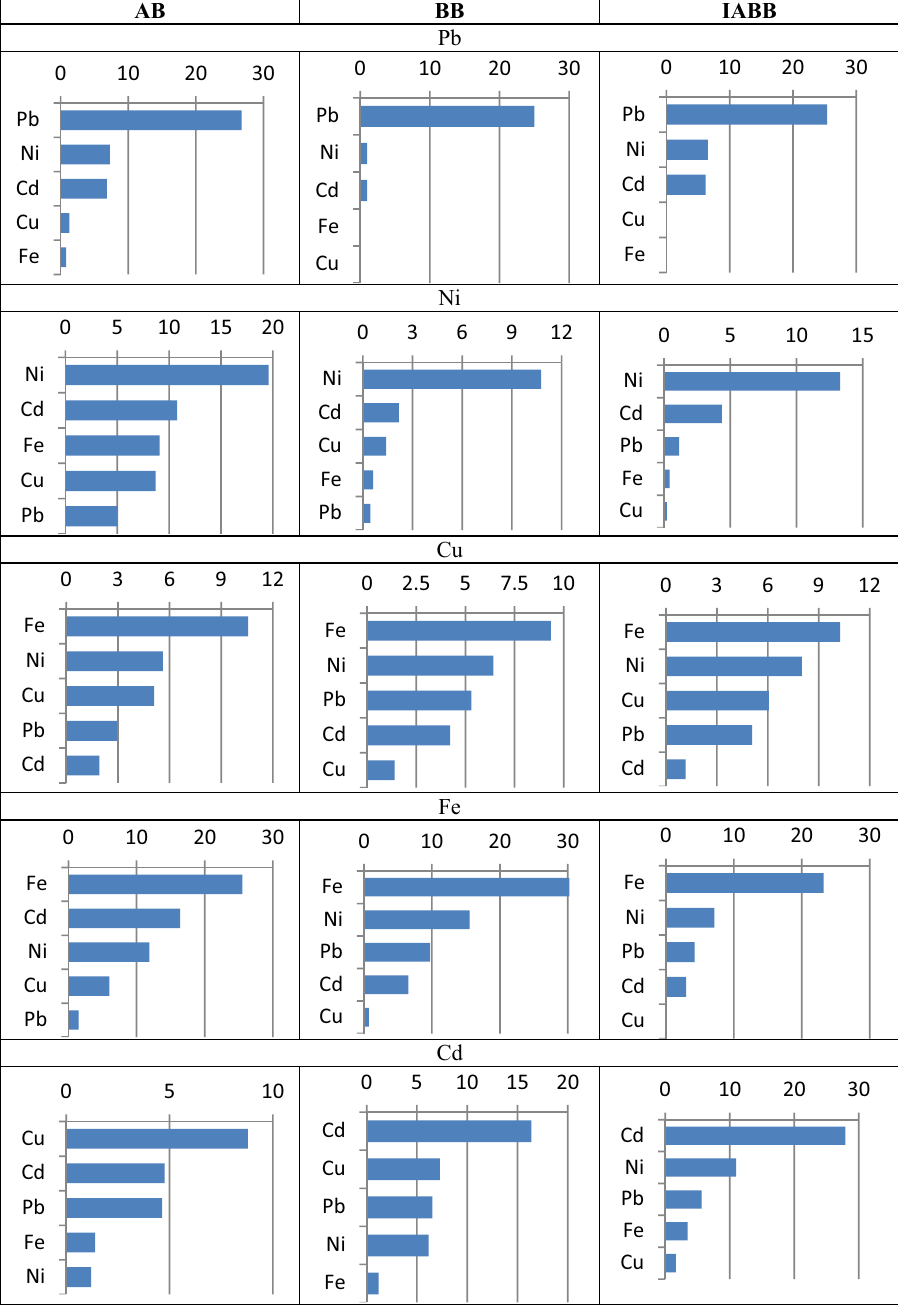
Figure 5. Pareto chart showing the effect of different heavy metals on each other’s removal by